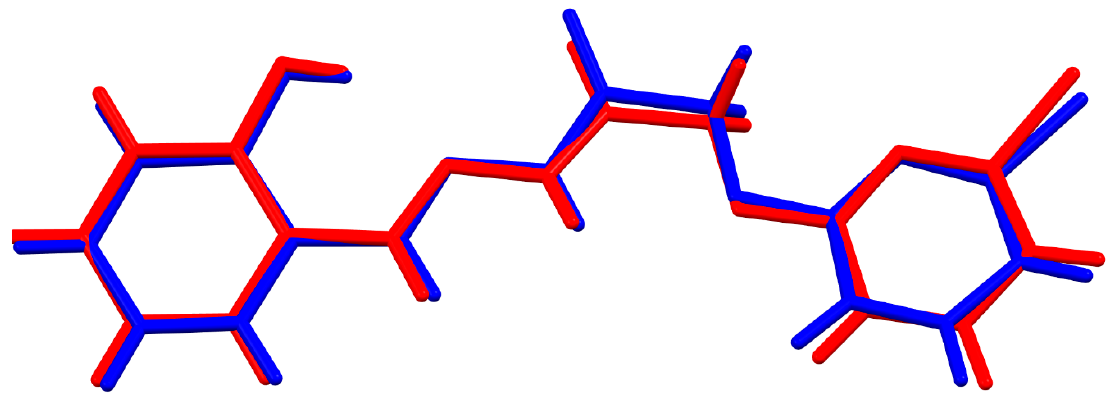
Figure 3. Molecular overlay of two crystallographically independent molecules: first molecule (red) and second molecule (blue) .